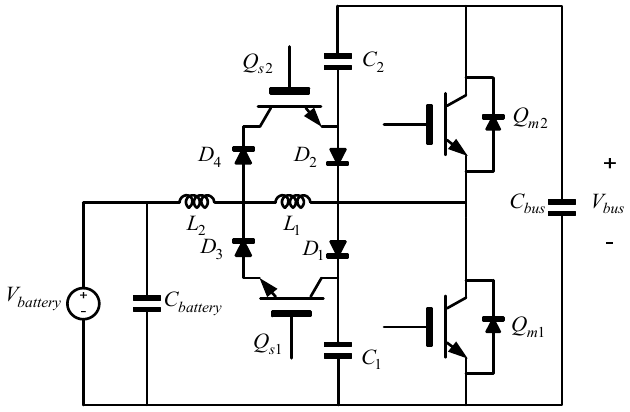
Figure 9. SAZZ bi–directional boost converter [20].